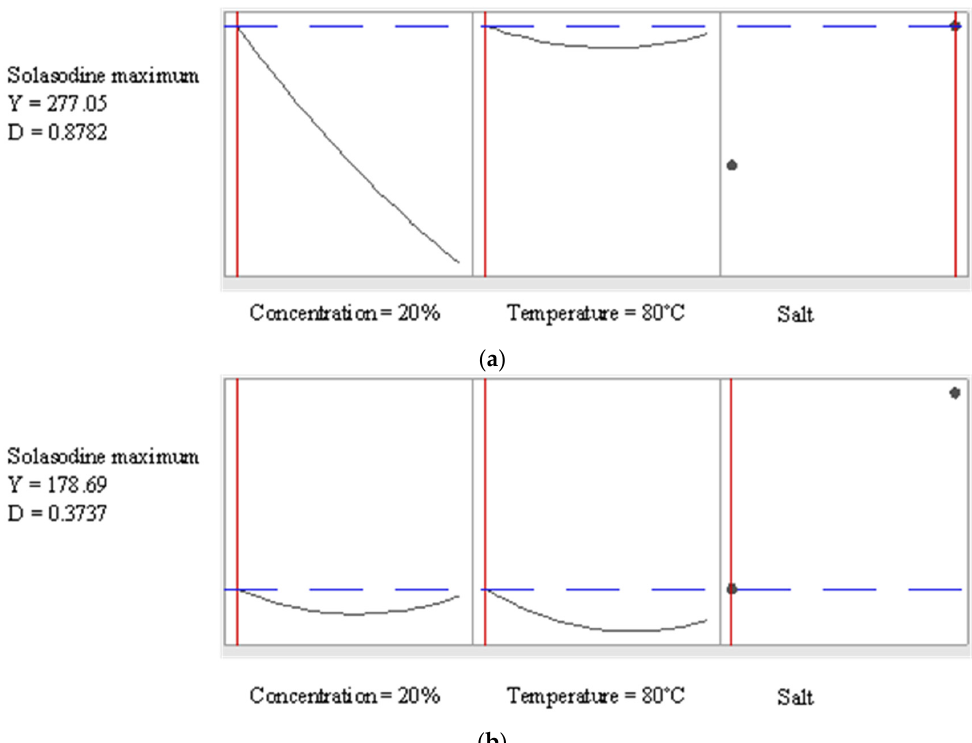
Figure 7. Response surfaces evaluating the effect of time and mass of plant powder in the presence of ( a ) Na 2 CO 3 and ( b ) NaCl on the extraction of solasodine.